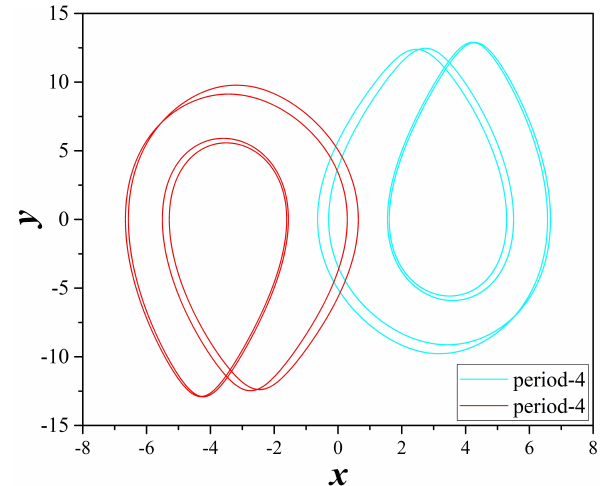
Figure 11. Coexisting attractors of system (2), for a = 4 × 10 − 4 , b = 1, c = 3.846 × 10 − 4 , e = 1 and d = 13. With cyan color and for ( x 0 , y 0 , z 0 ) = ( 0,0.1,0 ) a period-4 attractor, while with red color and